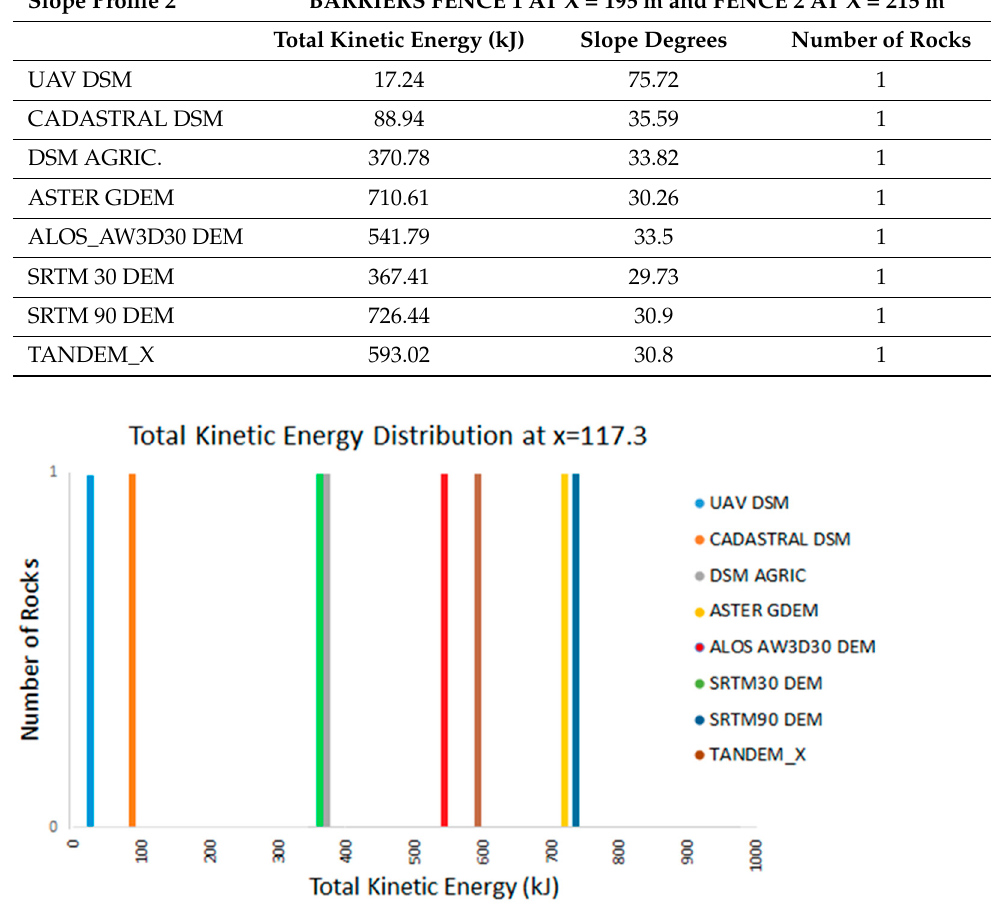
Figure 23. Total kinetic energy distribution at x = 117.3 m for the 2nd slope profile.